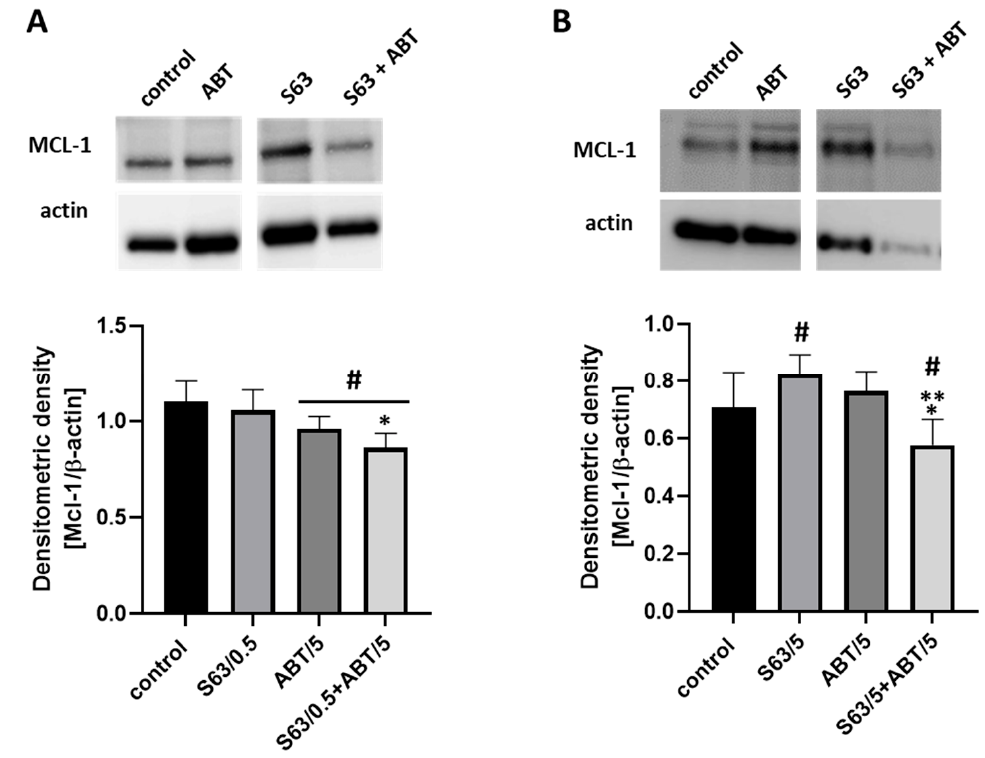
Figure 6. Expression of MCL-1 protein in HL-60 (panel A ) and ML-1 (panel B ) cells after treatment with S63845 (S63) and ABT-737 (ABT) alone and in combination for 48 h, detected by Western blotting. Relative levels of MCL-1 protein were quantified by densitometry and normalized to β -actin. Designations 0.5 and 5 indicate the agent concentrations ( µ M). Values are reported as the means ± SD of three independent experiments. Values significantly different ( p < 0.05) according to one-way ANOVA are designated by * and ** compared to, respectively, S63845 or ABT-737—single treated group; # compared to the corresponding control.